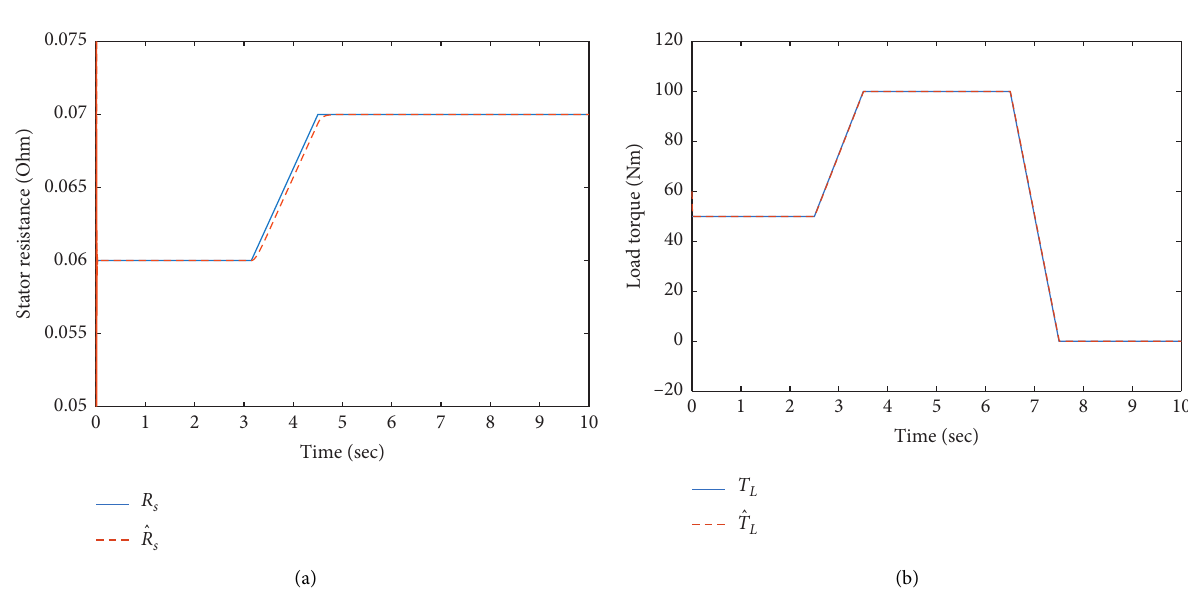
Figure 3: Evolution of R